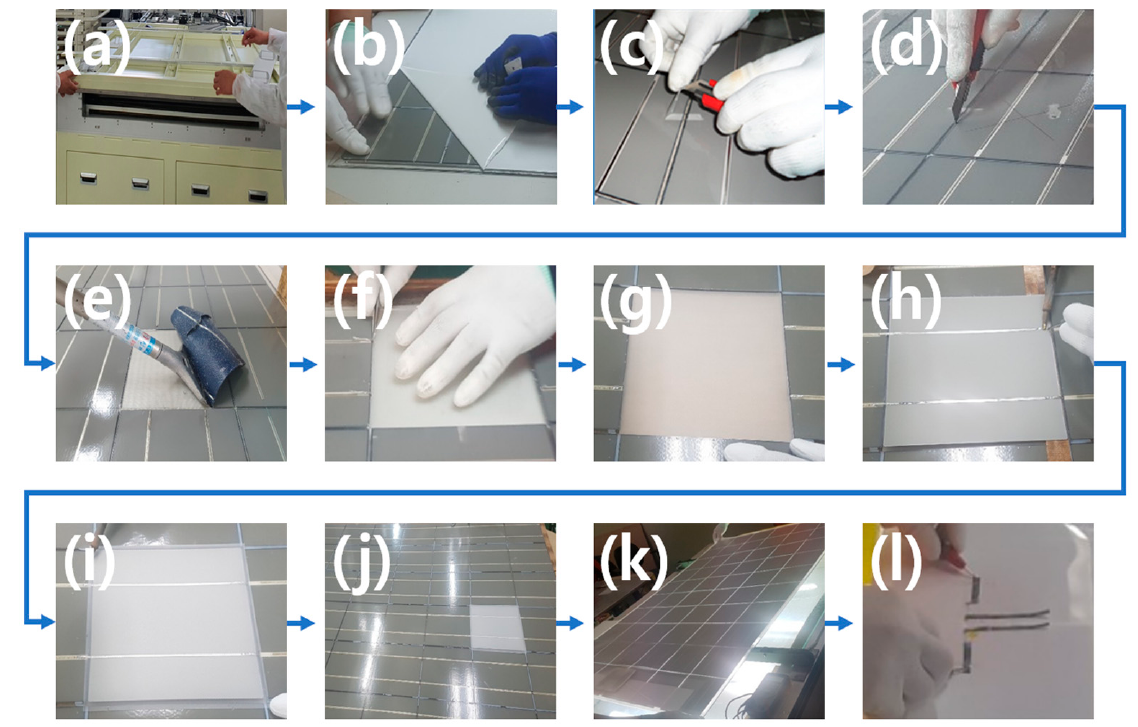
Figure 3. Module recovery process by replacing broken cells. ( d ) Next, the EVA along the boundary of the cell to be removed was cut, and the tab of the cell to be removed was cut by 15 mm or more for electrical connection during recovery. (e) Subsequently, the broken cell was removed using a scraper with a blade. ( f ) The remaining EVA was trimmed to the interface of the adjacent cells, and the removed surface was washed. After cell removal, the module was removed from the hot